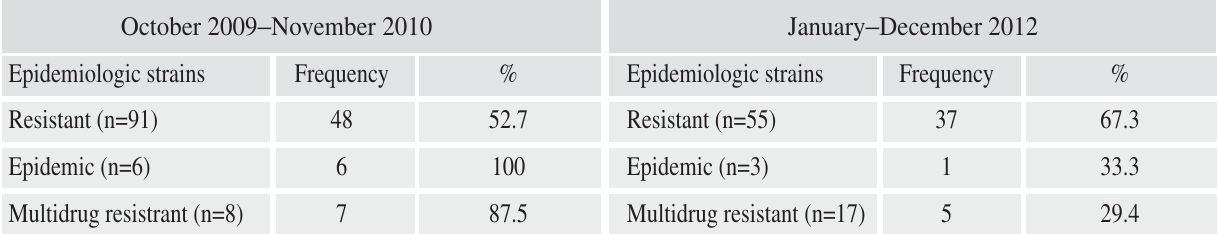
Table III: Pattern of azithromycin resistance among various epidemiological